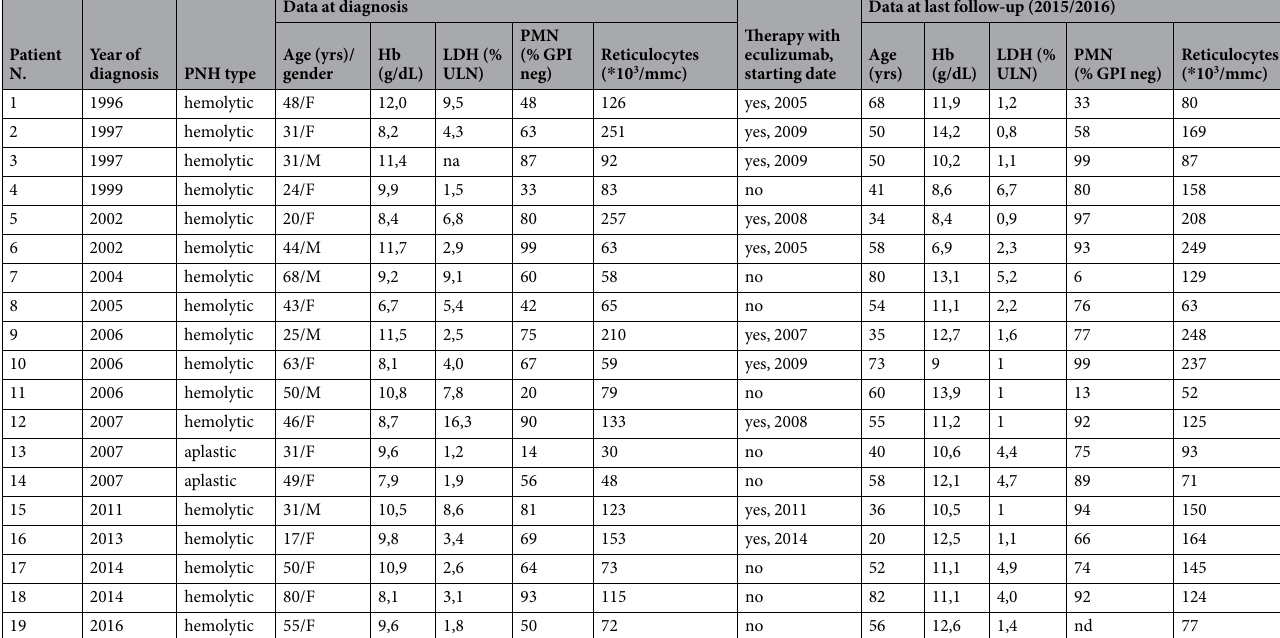
Table 1. Clinical and hematologic parameters of PNH patients. t > ULN: times over the upper limit of normal, nd: not done, na: not available. Median values at diagnosis: WBC were 3.68 × 10 3 /mmc (range 1.7–7.04 × 10 3 / mmc); PMN 2.22 × 10 3 /mmc (0.5–3.7 × 10 3 /mmc); PLT 160 × 10 3 /mmc (38–362 × 10 3 /mmc); Median values at last follow up: WBC 3.91 × 10 3 /mmc (2.6–5.04 × 10 3 /mmc); PMN 2.24 × 10 3 /mmc (1.16–2.76 × 10 3 /mmc); PLT 159 × 10 3 /mmc (range 81–322 × 10 3 /mmc); Normal ranges: WBC 4.8–10.8 × 10 3 /mmc; PMN 1.50–6.50 × 10 3 / mmc; PLT 130–400 × 10 3 /mmc; Hb male 13.5–17.5 g/dL, Hb female 12.0–16 g/dL; LDH 135–214 U/L; Reticulocytes 20–100 × 10 3